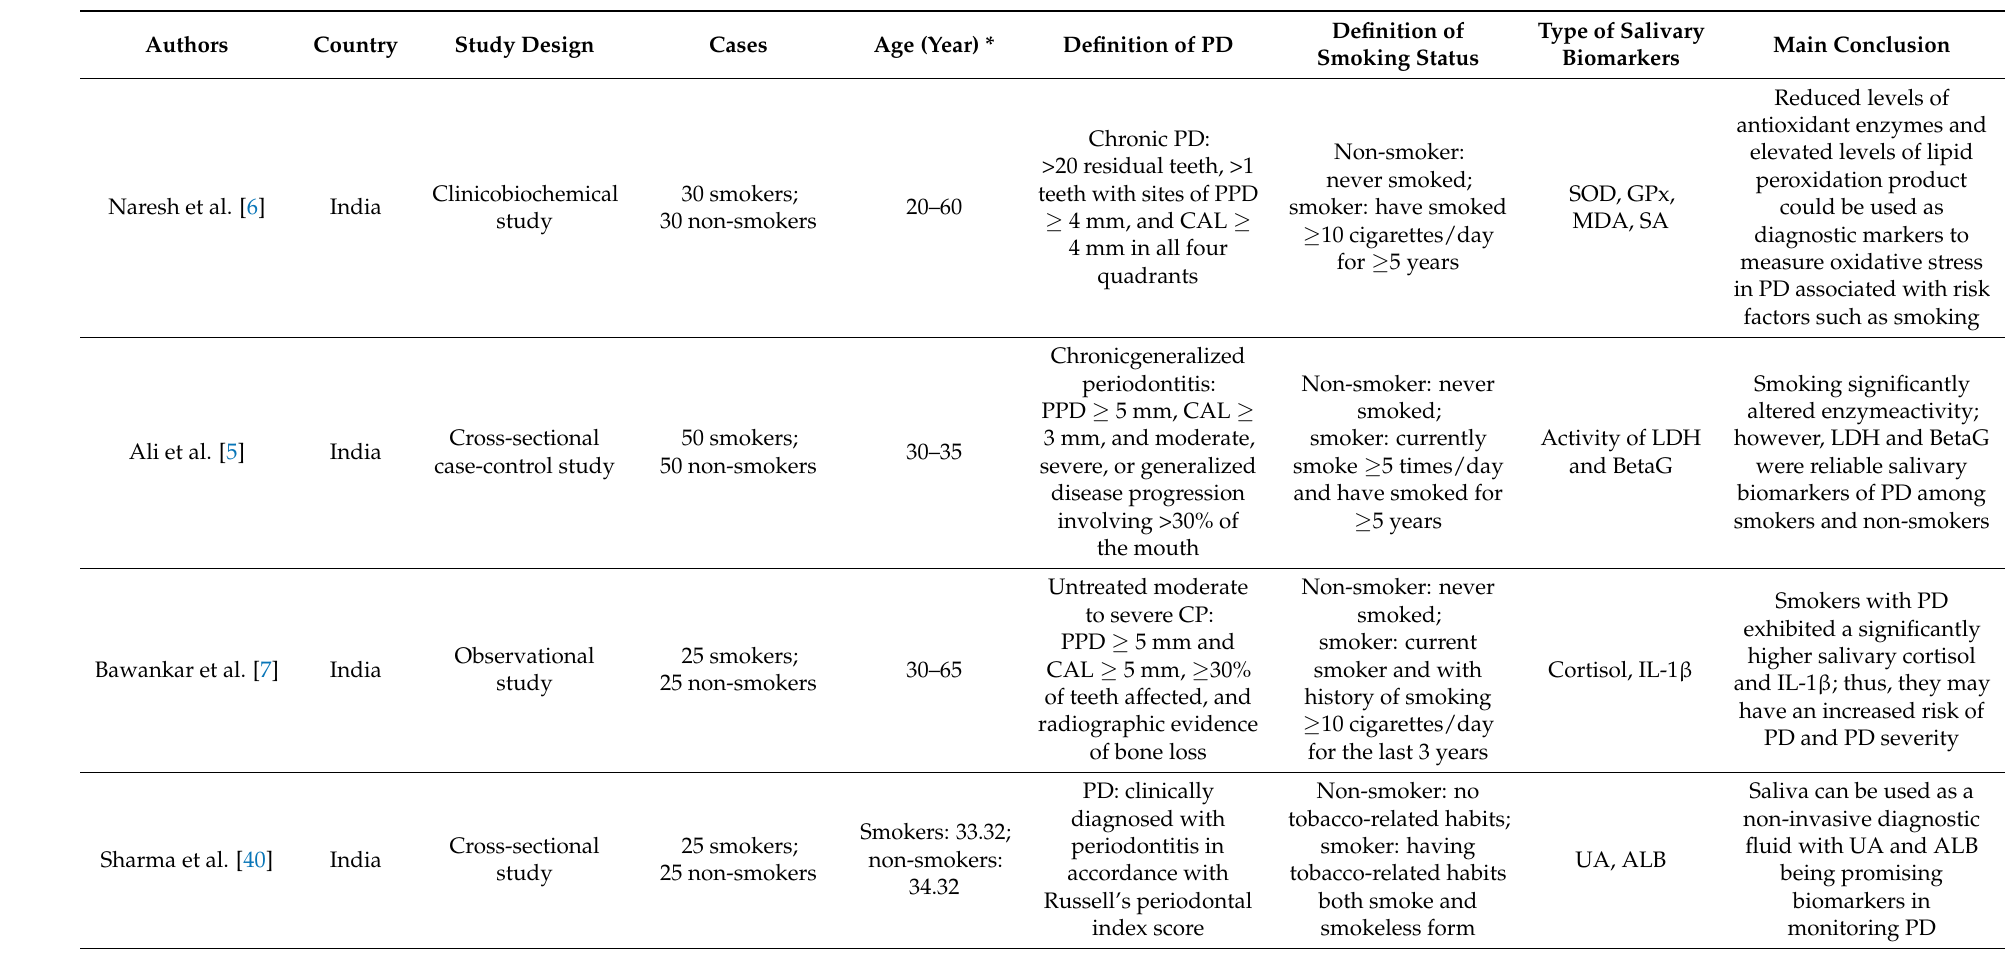
Table 3. Descriptive summary of the included studies in the systematic